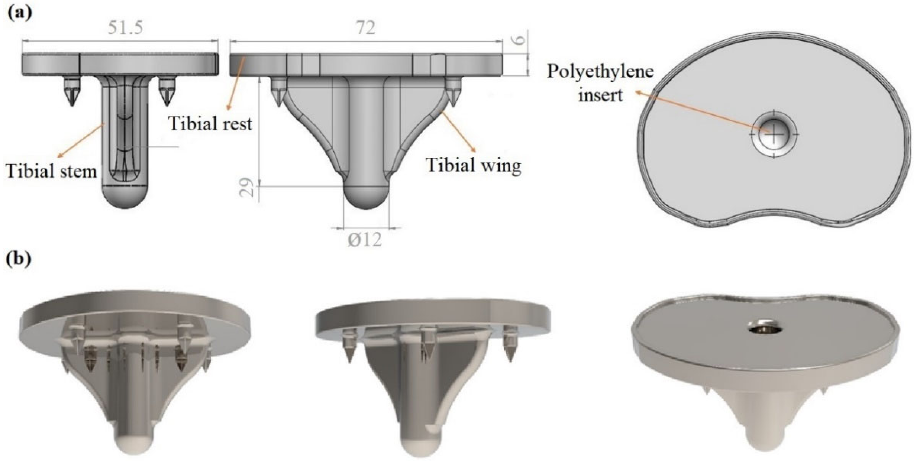
Figure 4. ( a ) 3D model of the initial implant with basic dimensions; ( b ) Rendered images of the final implant’s design.